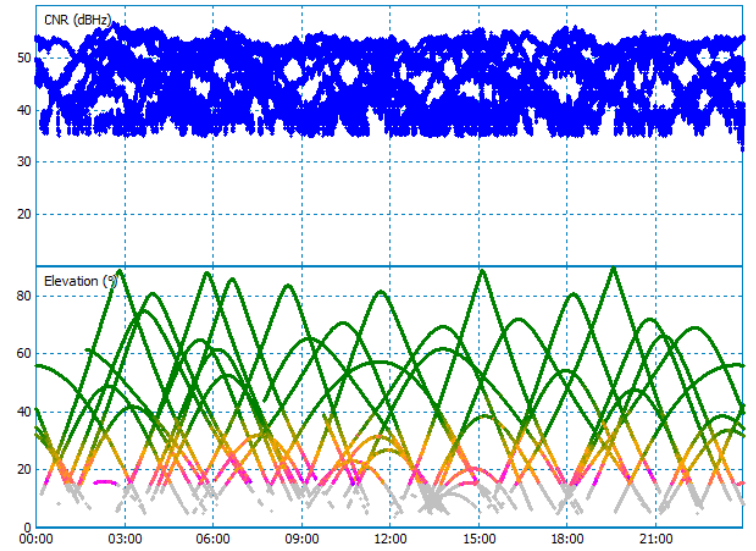
Figure 3. An example of CNR of all GPS satellites with satellite elevation angles in 24 h.